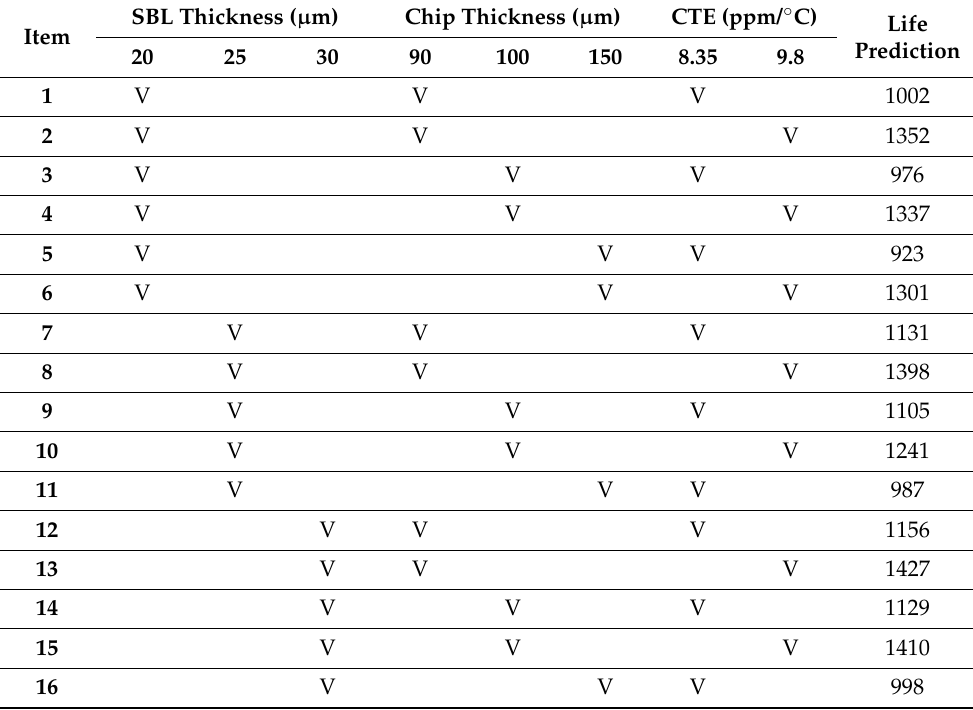
Table 4. Combination of the design parameters in the parametric analysis of the FO-WLP PoP.